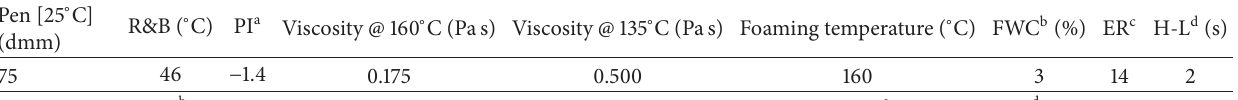
Table 2: Characteristics of bitumen.